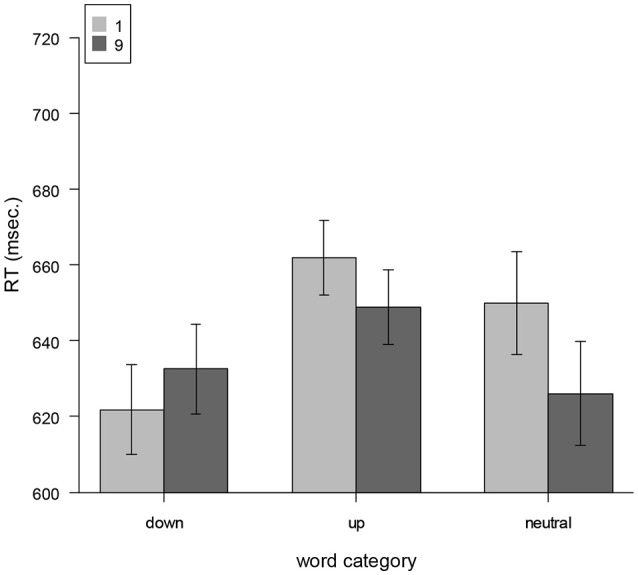
Mean reaction times as a function of implicit locational association of words (up, down, neutral) and numbers (high, low). Error bars represent 95% confidence intervals.